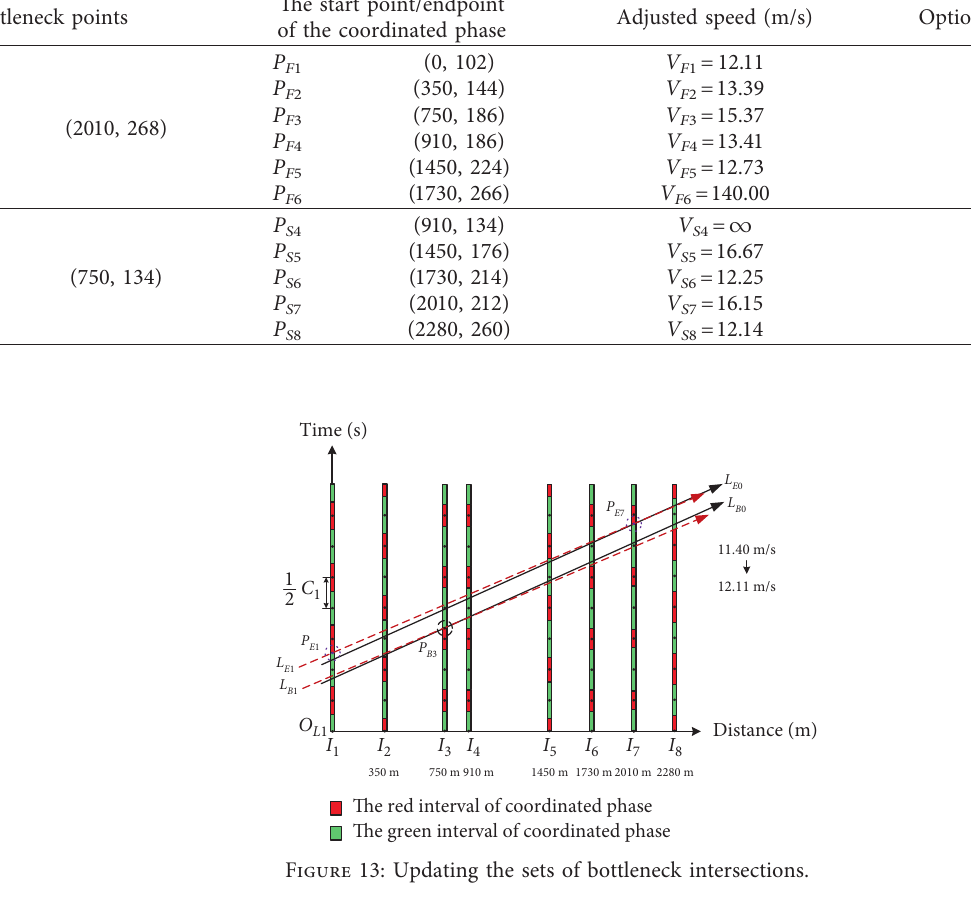
Table 1: The optional vehicle speed set during the first rotation transformation in the second round. Bottleneck points